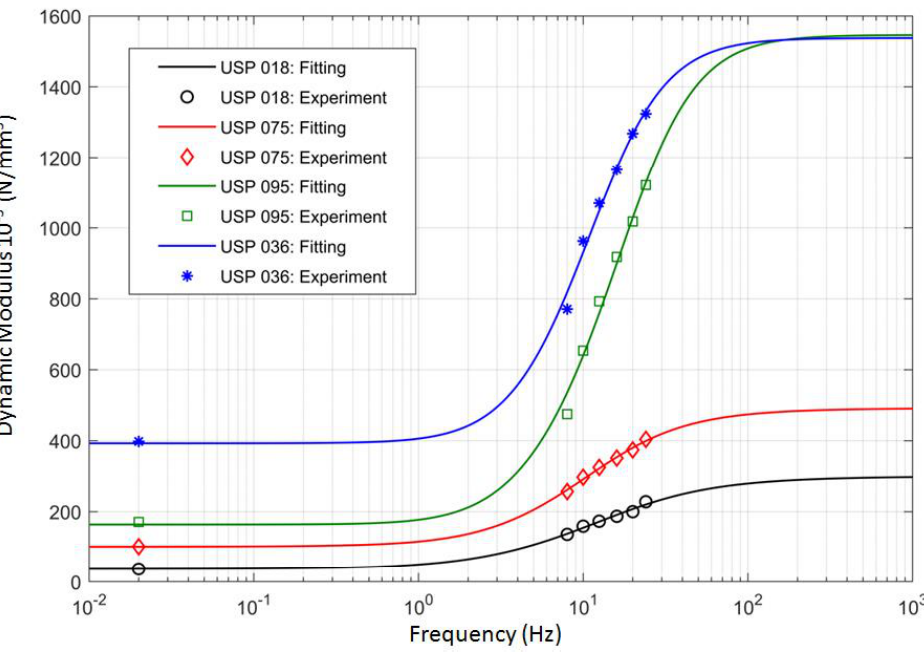
Figure 8. Curve fitting results for the four analyzed USP models.